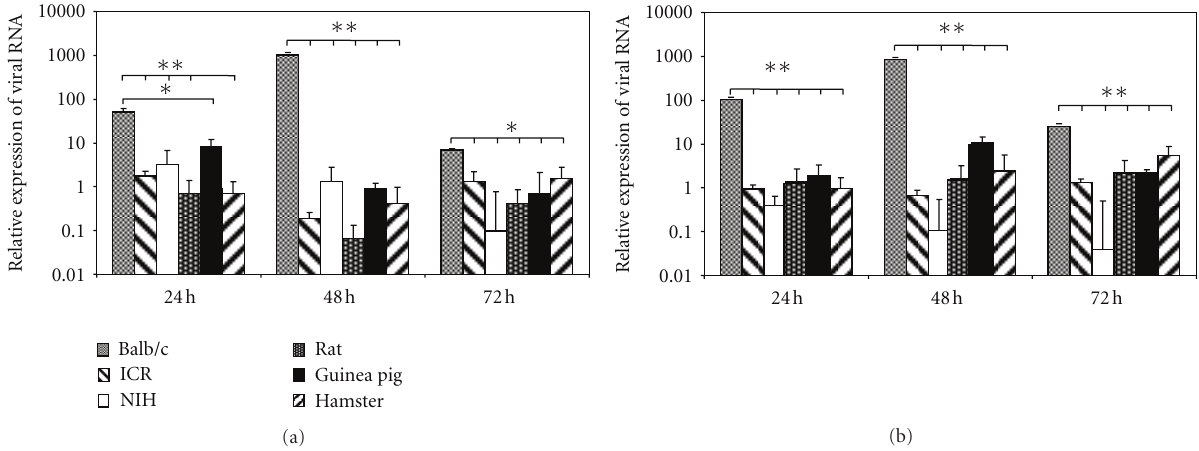
Figure 2: qRT-PCR to obtain relative quantification of viral copies obtained from monolayers from di ff erent rodents’ peritoneal macrophages cultures. The fold change of viral RNA was calculated from DENV-infected macrophage monolayers, normalising the data obtained against noninfected control and against β -actin at 0,1MOI (a) and at 1MOI (b) and evaluated 24, 48, and 72 hours p.i. ∗ P < 0 . 05, ∗∗ P < 0 . 01.